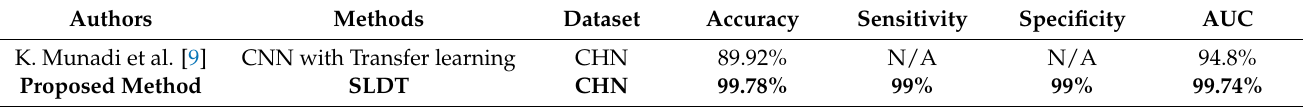
Table 1. Performance measures of the proposed method with the existing method by the CHN dataset.